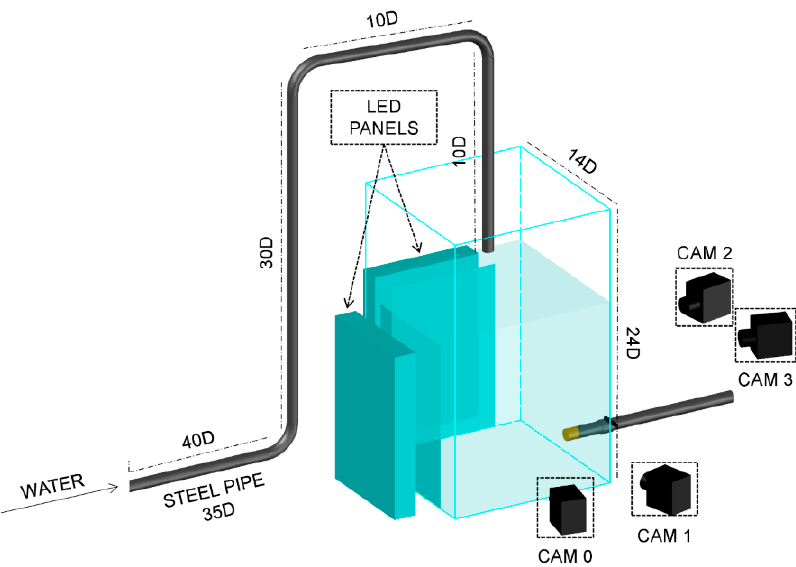
Figure 2. Experimental setup.